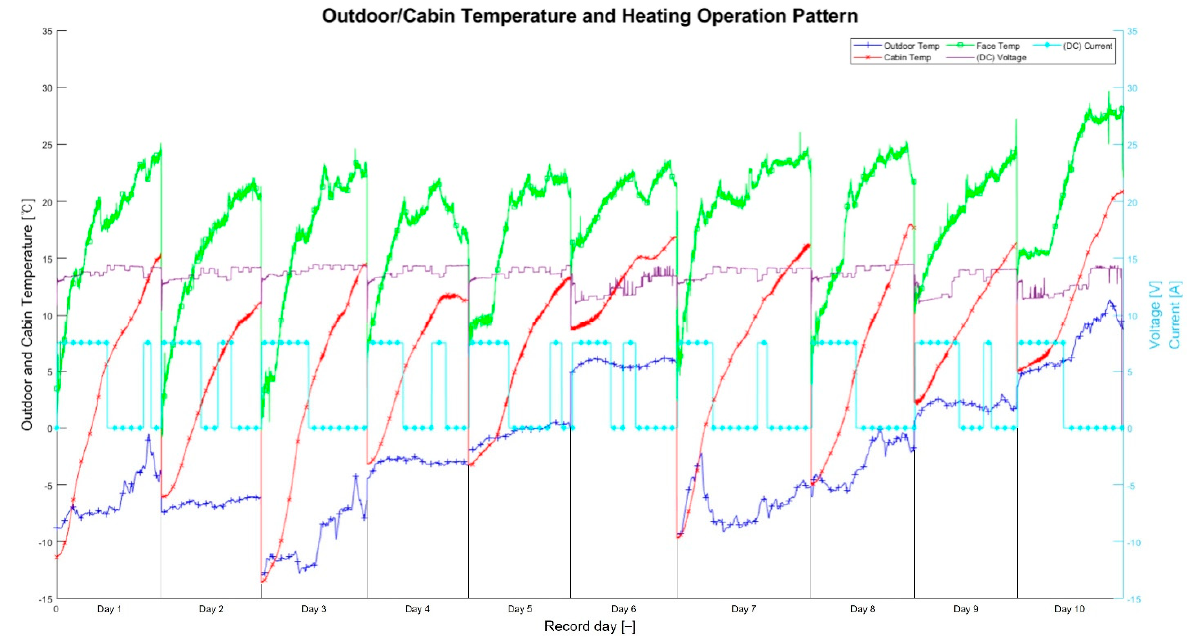
Figure 4. Outdoor and cabin temperature of a vehicle.